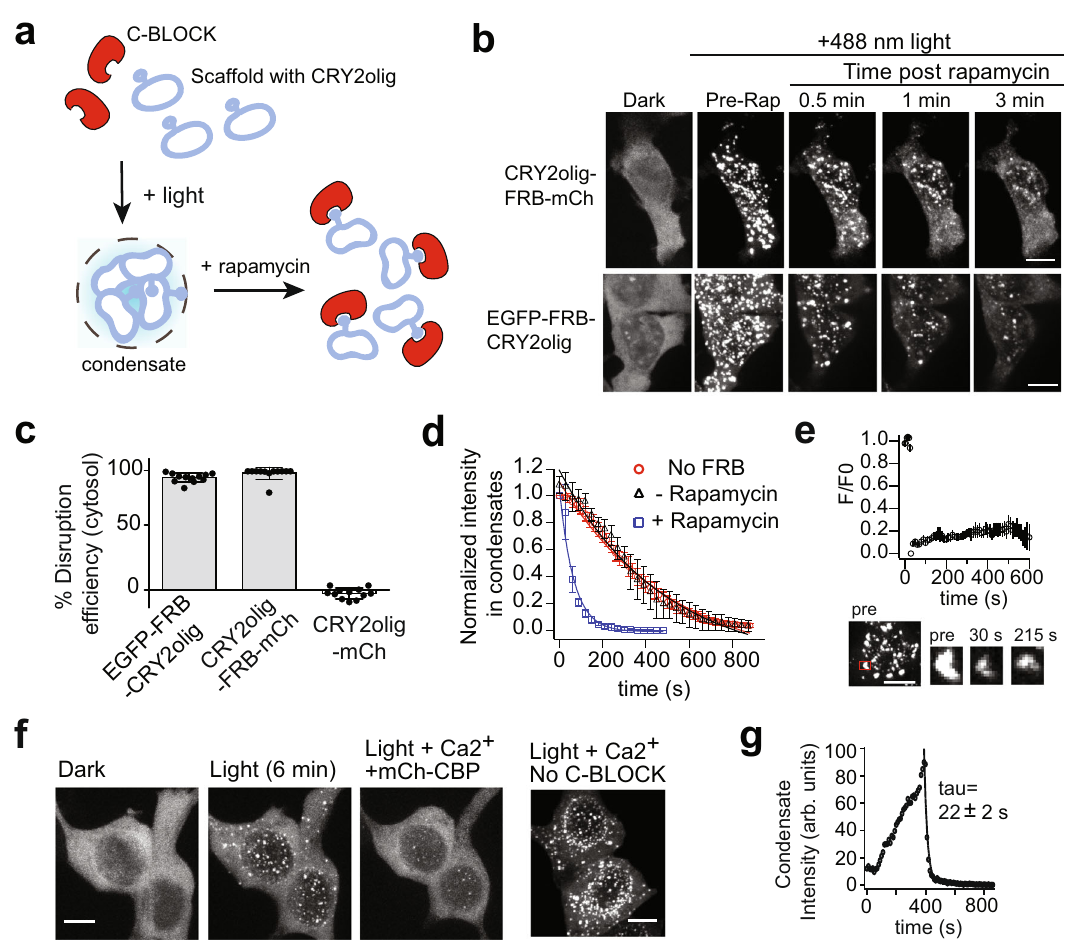
Fig. 4 Light-activated CRY2olig condensates can be disrupted using DisCo. a Schematic of DisCo approach with CRY2olig. Light triggers condensate formation, while rapamycin-mediated recruitment of C-BLOCK to a FRB ‘ hook ’ on CRY2olig scaffold disrupts condensates. b , c CRY2olig condensates are disrupted equally regardless of recruitment orientation. DisCo was performed on HEK293T cells expressing CRY2olig-FRB-mCh and mCh(K70N)-FKBP, or EGFP-FRB-CRY2olig and mCh-FKBP. Cells were illuminated with light (488 nm, 100 ms every 30 s) at 18 – 22 h post-transfection, then 333 nM rapamycin was added 5 min after light onset. Representative images shown in ( b ), with quanti fi cation of cytosolic disruption in ( c ). Data were quanti fi ed as in Fig. 1c and represent average and error (s.d., n = 10 cells examined from three independent experiments). Scale bars, 10 µ m. d Kinetics of condensate disassembly. HEK293T cells expressing CRY2olig-FRB-mCh and mCh(K70N)-FKBP were illuminated 5 min (488 nm, 100 ms pulse every 20 – 30 s), 18 – 22 h after transfection. Black triangles, dark, no rapamycin. Blue squares, light (488 nm, 100 ms pulse every 30 s), 333 nM rapamycin. Red circles, control cells expressing CRY2olig-mCh (no FRB) and mCh(K70N)-FKB, with 333 nM rapamycin in dark. All experiments were performed at 33.5 °C. Data shows average and error (s.d., n = 5 cells examined from three independent experiments). e FRAP experiments with EGFP-FRB-CRY2olig condensates formed after 3 min light treatment. Data shows average and error (s.e.m, n = 6 cells examined from three independent experiments). Representative images of a photobleached condensate are shown at bottom. Scale bars, 10 µ m. f Ca 2 + -dependent DisCo. HEK293T cells expressing EGFP-CaM-CRY2oligC9 and mCh- CBP formed condensates with light (488, 100 ms pulse every 30 s for 6 min). Addition of 2.5 mM CaCl 2 and 3 µ M ionomycin resulted in condensate disruption. Image at far right shows control experiments subject to the same light and Ca 2 + treatments, but without C-BLOCK. The experiment was repeated a second time with similar results. Scale bars, 10 µ m. g Quanti fi cation of kinetics and extent of Ca 2 + -dependent disruption of CRY2olig condensates in experiments shown in ( f